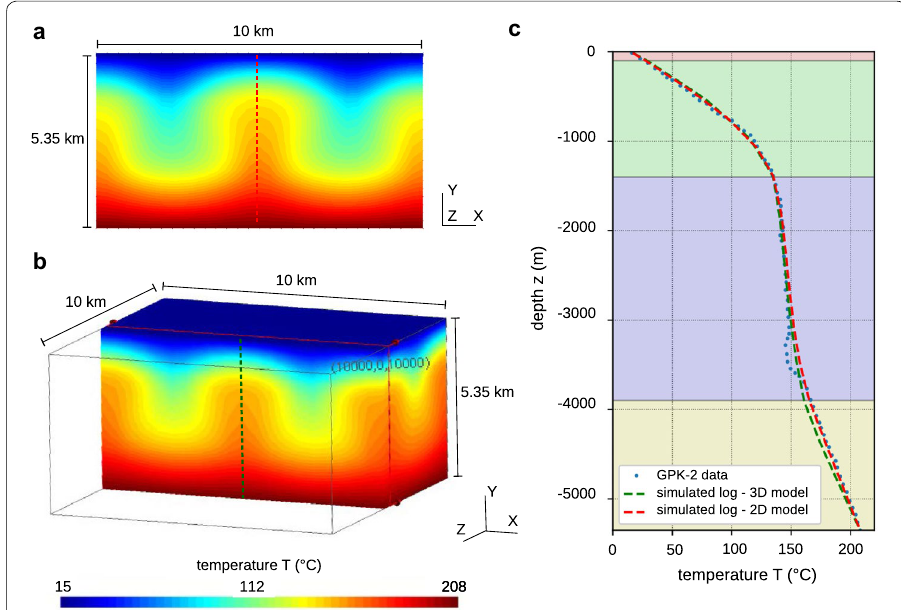
Fig. 5 a Map of calculated temperatures (background colors) from a 2D model being 5.35 km in height and 10 km in width. The red dashed line is the location of the simulated profile shown in c . b Map of calculated temperatures (background colors) from 3D model having a height of 5.35 km and their two horizontal dimensions both set to 10 km. The green dashed line is the location of the simulated profile shown in c . c Comparison of the simulated temperature profile obtained at the middle of the mesh grid between the 2D model (in red) and the 3D model (in green). The blue dashed line corresponds to the observed profile at GPK-2 well and the background colors to the idealized layers homogenized at the scale of 100